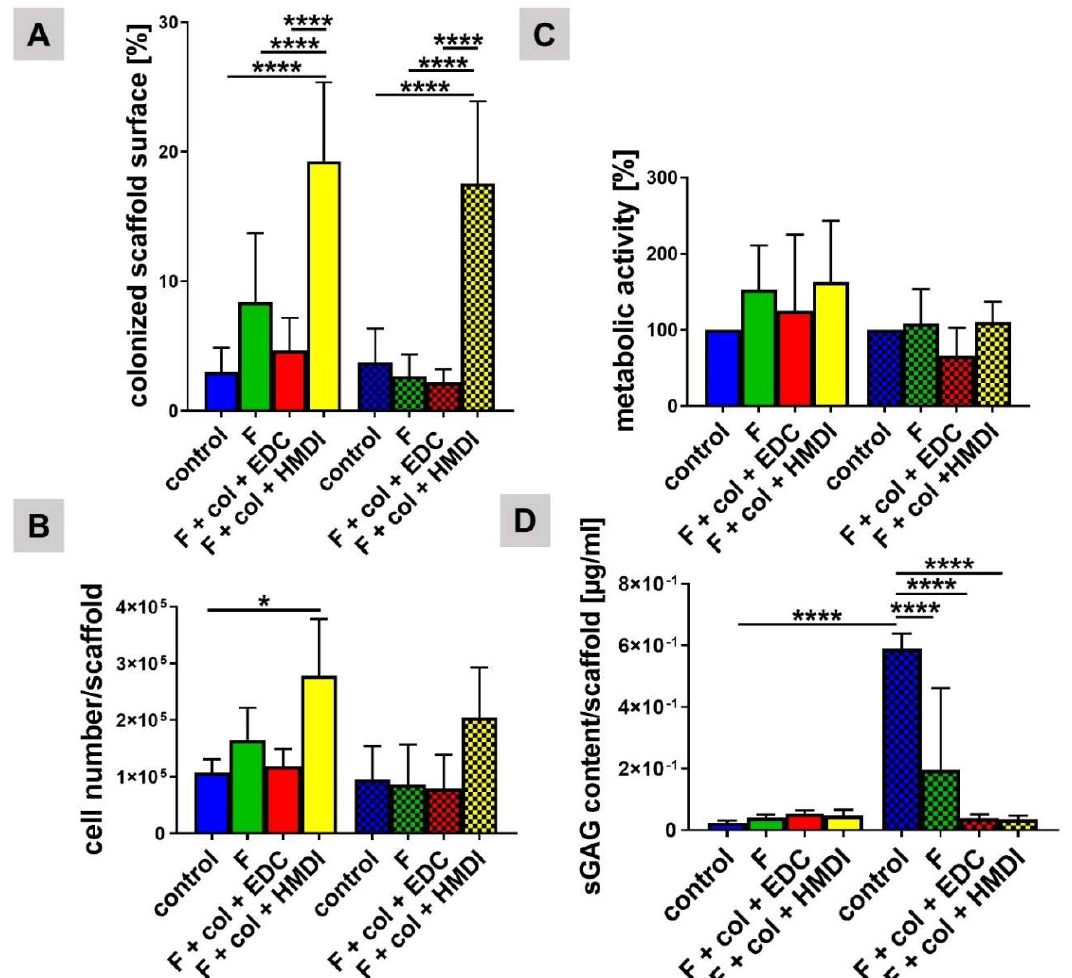
Figure 5. E ff ect of fluorination and di ff erent collagen cross-linking methods on sca ff old colonization, metabolic activity, cell numbers and sGAG synthesis of dynamically cultured LACL-derived fibroblasts. Results of colonized sca ff old surface calculation ( A ), n = 9 independent experiments with LACL-derived fibroblasts of di ff erent donors, results of CyQuant Assay ( B ), n = 3 independent experiments with LACL-derived fibroblasts of di ff erent donors, Alamar Blue Assay to assess metabolic activity ( C ) and dimethyl methylene blue (DMMB) Assay ( D ) after 7 days (fully marked) and 14 days (check marked), n = 3 independent experiments with LACL-derived fibroblasts of di ff erent donors. One sample t test, two-tailed (comparison of di ff erent concentrations with control), one-way ANOVA (post hoc Tukey Test) for comparison between the groups. p values: * < 0.05, **** < 0.0001. Col, collagen foam; F, fluorinated; EDC, ethylcarbodiimide cross-linked; HMDI, hexamethylene diisocyanate